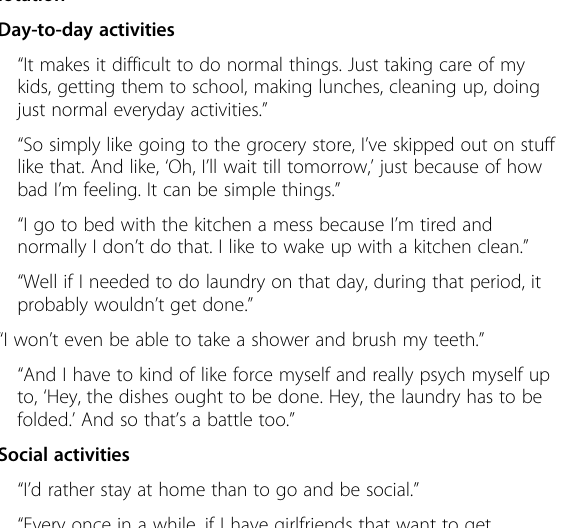
Table 5 Impacts of Endometriosis-Related Fatigue on Mood and Emotions, Relationships With Family/Partner, and